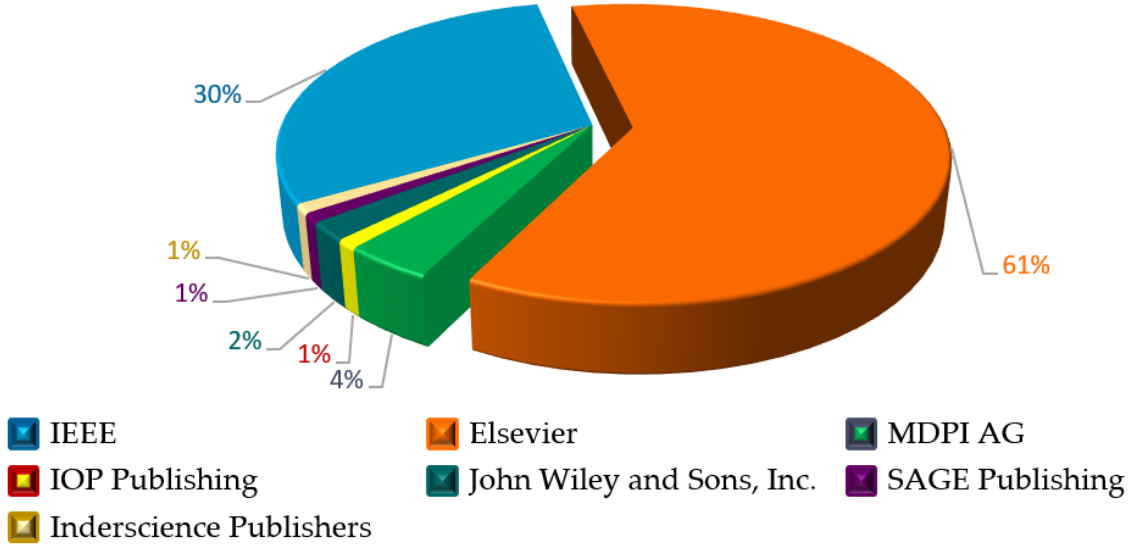
Figure 6. Distribution of published manuscripts according to publishers.